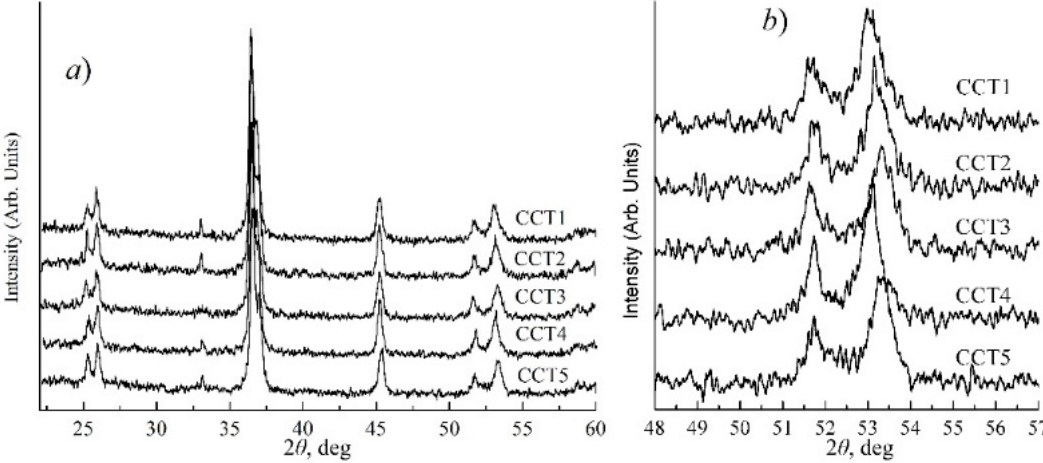
Figure 3. X-ray diffraction patterns of PCR-13 material produced by CCT under different sintering conditions: CCT1 at 𝑇 𝑠𝑖𝑛𝑡. = 1520 K for 2 h with backfill; CCT2 at 𝑇 𝑠𝑖𝑛𝑡. = 1500 K for 2 h with backfill; CCT3 at 𝑇 𝑠𝑖𝑛𝑡. = 1500 K for 5 h with backfilling; CCT4 at 𝑇 𝑠𝑖𝑛𝑡. = 1520 K for 2 h without backfill; CCT5 at 𝑇 𝑠𝑖𝑛𝑡. = 1520 K for 5 h without backfill ( a ); fragments of X-ray patterns, including lines (200) c ( b ).